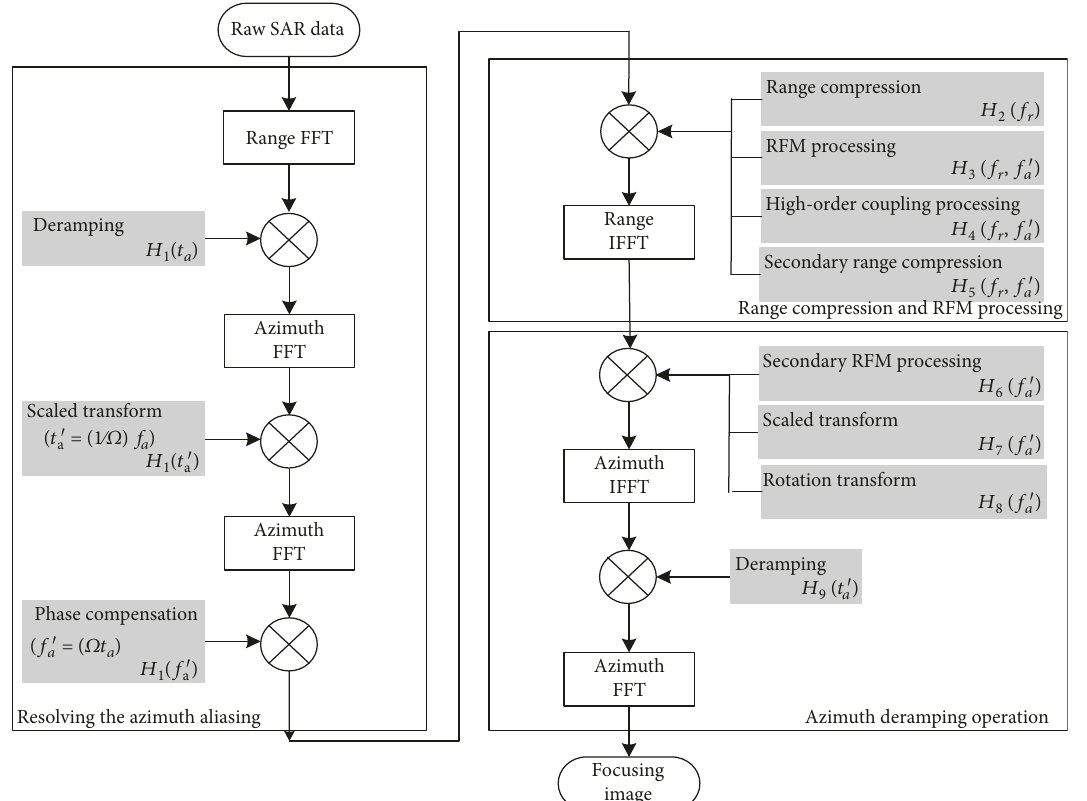
Figure 2: Diagram of the GEO-UAV BiSAR imaging